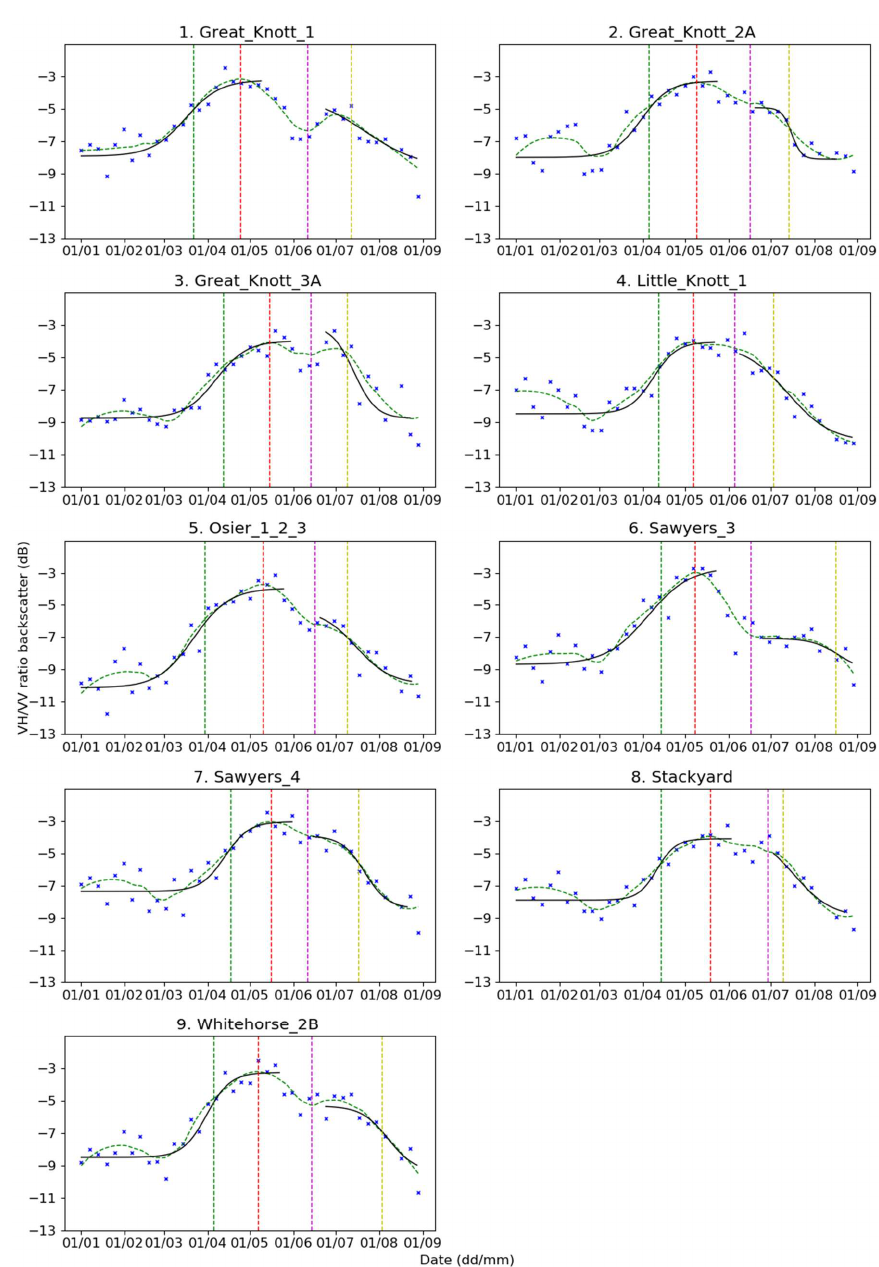
Figure 6. VH / VV ratio time series (blue dots) with the smoothed curve (dotted green line) and two logistic curves fitted (black line) for nine fields (subplots 1–9) during 2017, orbit 132. The vertical dotted lines indicate the dates of G_midP (green), TZmax (red), inflorescence (purple), and S_midP (yellow), as determined from the VH/VV backscatter time series analysis.